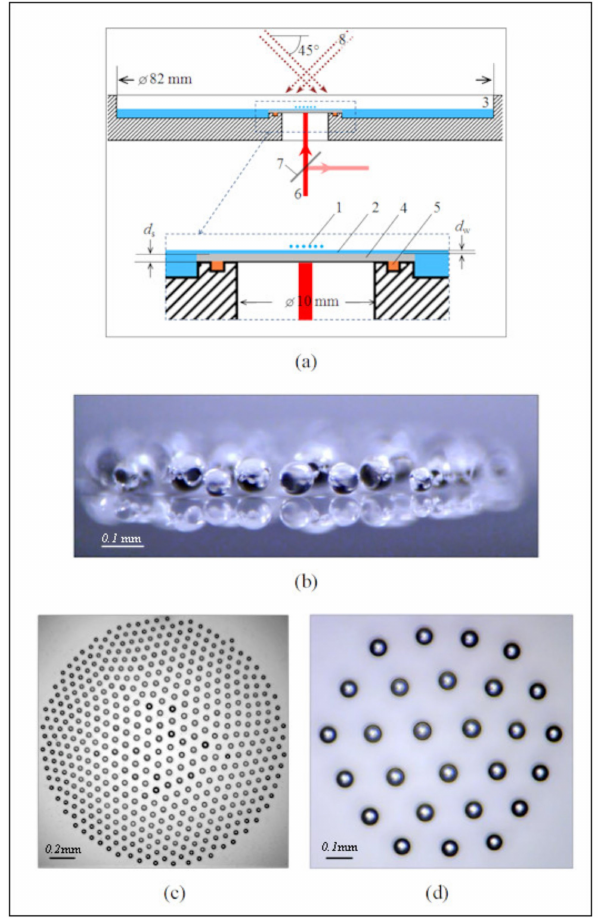
Figure 6. ( a ) the schematic of experimental setup for the droplet cluster (adopter from [19]), ( b ) side view of a cluster (adopted from [21]) and top views of a ( c ) large [15] and ( d ) small